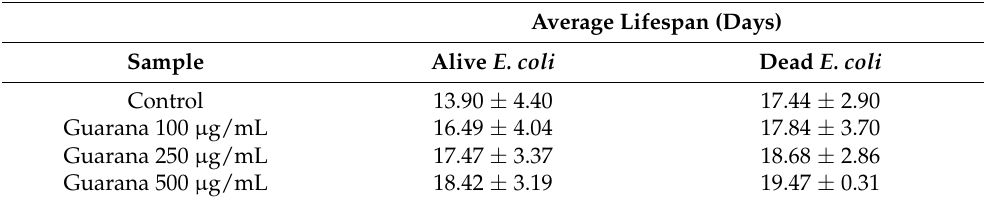
Figure 3. ( a ) Percentage of survival of SS104 glp -4 animals (25 ◦ C) fed with live E. coli OP50 and treated with different concentrations of guarana, 100 ( n = 120), 250 ( n = 119) and 500 ( n = 111) µ g/mL compared with the control ( n = 125). ( b ) Percentage of survival of SS104 glp- 4 animals (25 ◦ C) fed with dead E. coli OP50 and treated with different concentration of guarana, 100 ( n = 98), 250 ( n = 120) and 500 ( n = 111) µ g/mL compared with the control ( n = 115). Results are expressed as mean ± SD. Table 3. Average lifespan of SS104 glp -4 animals fed with live or dead E. coli OP50. Results expressed as days ±